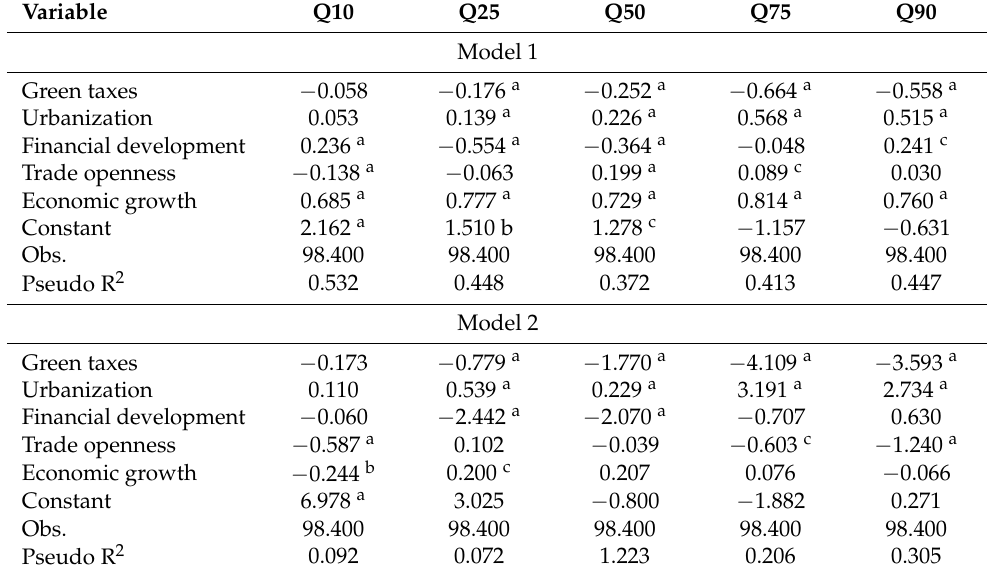
Table 7. Quantile regression extended in